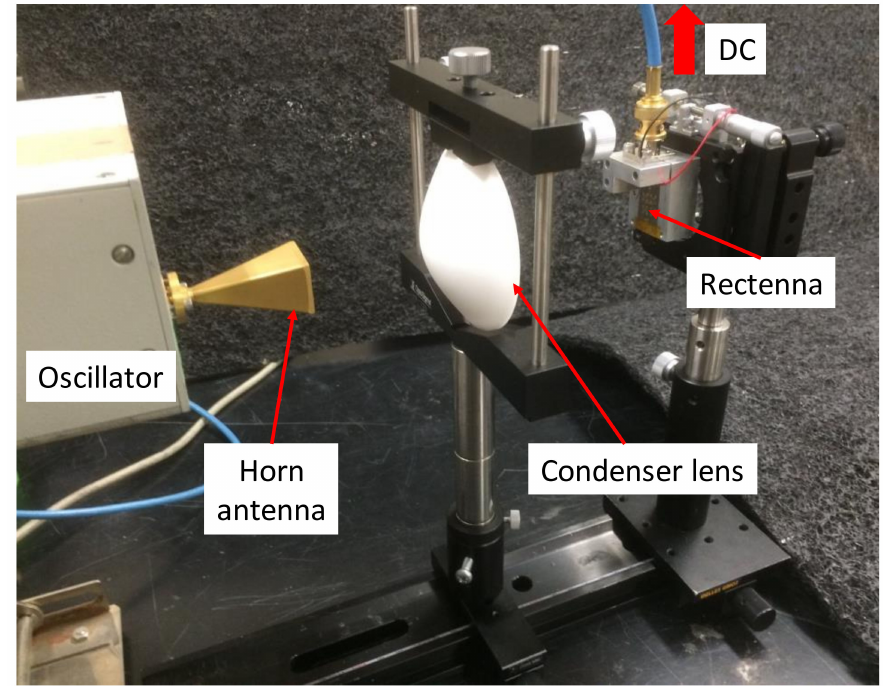
Figure 17. Measurement setup of 94 GHz wireless power